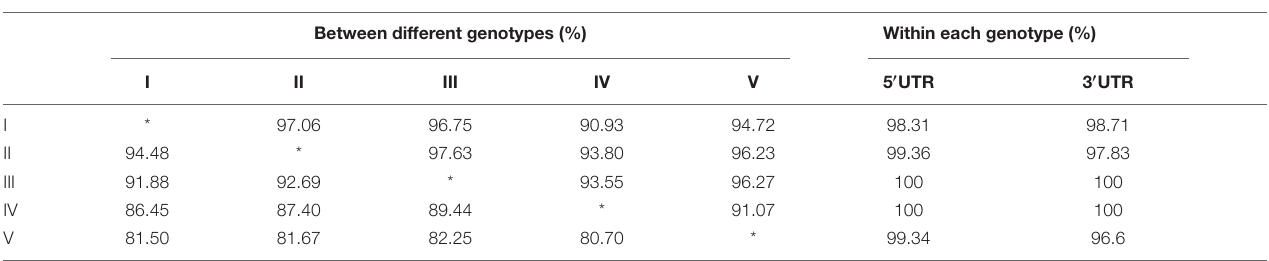
TABLE 4 | The average nucleotide similarity of the JEVs’ UTRs. Between different genotypes (%) Within each genotype